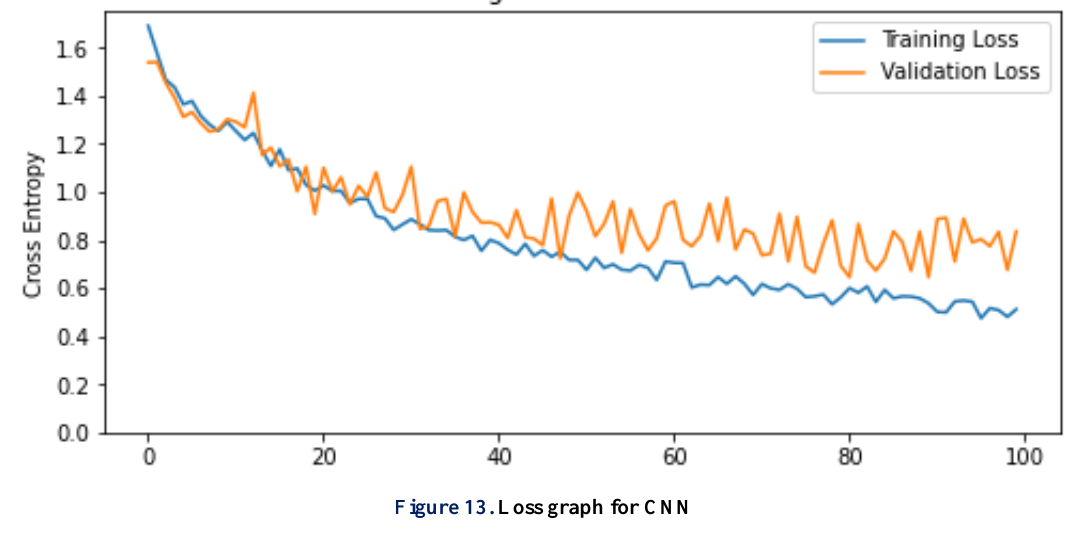
Figure 13. Loss graph for CNN